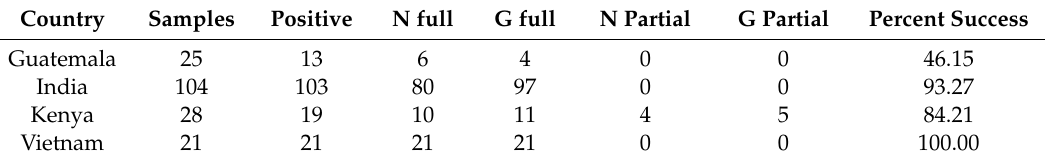
Table 5. Success rate of MinION sequencing in Guatemala, India, Kenya, and Vietnam. The total number of positive samples was based on the result of diagnostic testing in the local laboratory; for Guatemala, Kenya, and Vietnam, all positive samples were confirmed by the LN34 real-time PCR assay. Only 19 samples from India were confirmed positive by LN34 PCR (see Table S1 for additional details). The number and percent of positive samples where N or G gene sequences were produced is shown for each